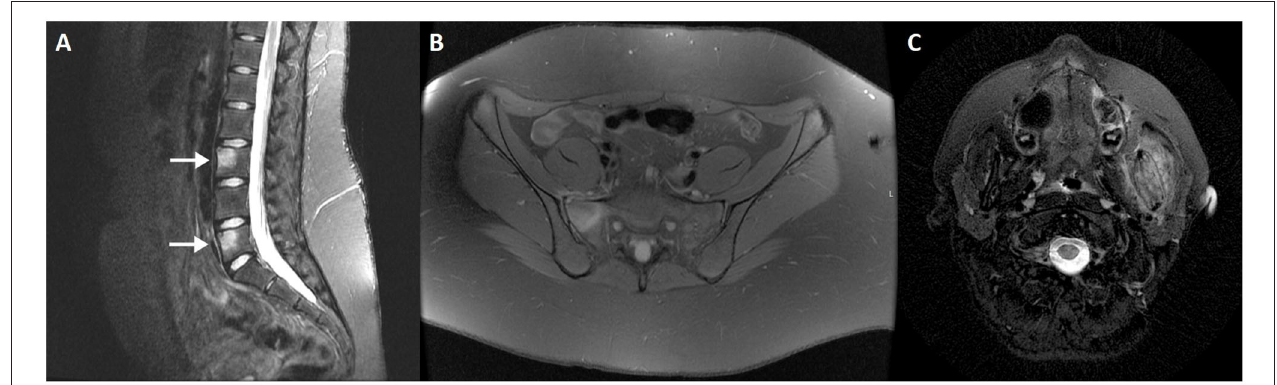
FIGURE 10 | Fat-saturated T2WI sagittal MRI sequence (A) of the lumbar spine in a 16-year-old female patient with CRMO (arrows), mimicking corner inflammatory lesions. Fat-saturated PD axial slice (B) of the same patient depicting involvement of the right SIJ. Fat-saturated T2WI axial slice (C) of the neck shows involvement of the left mandibular